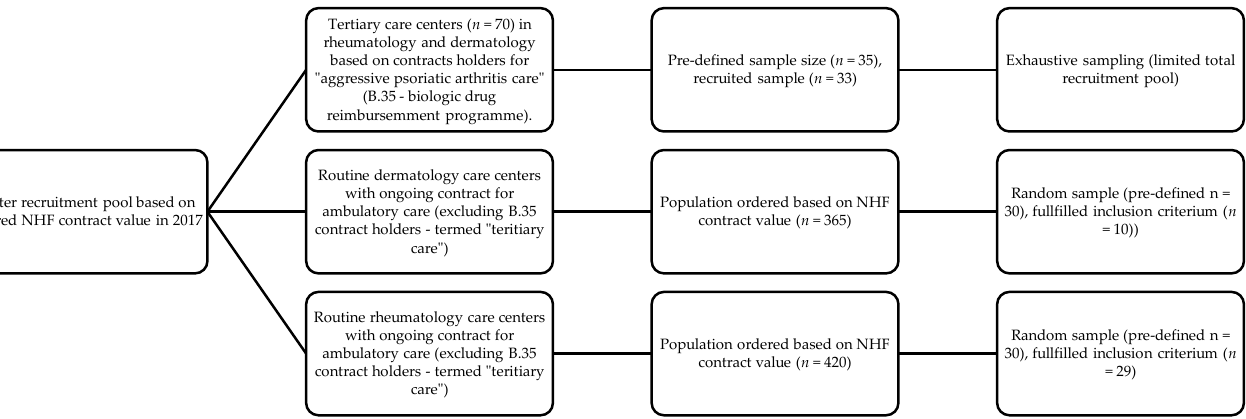
Figure 1. Process of recruiting rheumatology and dermatology care centers into the study.